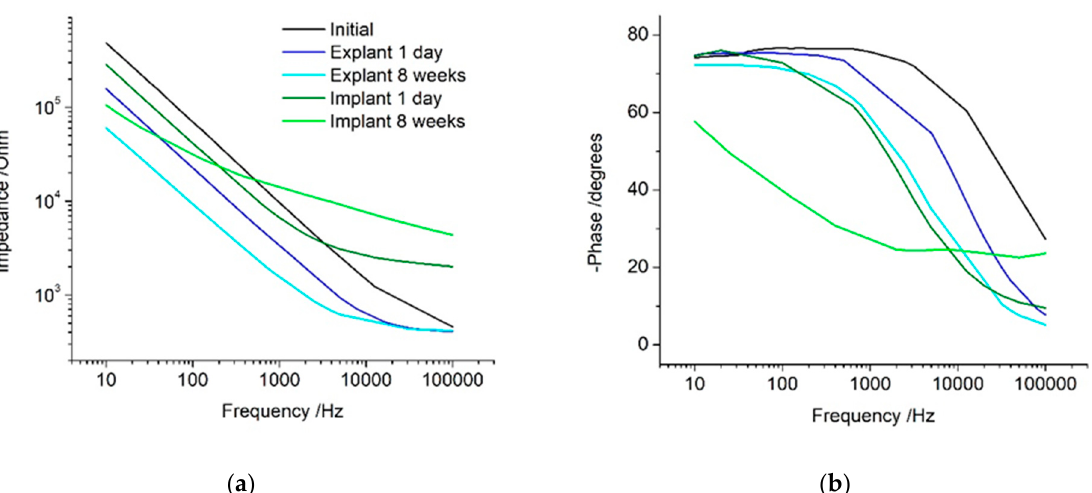
Figure 5. ( a ) Impedance; ( b ) Phase Angle. Electrochemical impedance spectroscopy of a platinum cochlear implant electrode at 0 V with an AC amplitude of 10 mV before cyclic voltammetry. Electrode initially tested in saline, implanted in a cochlea for 1 day, explanted after 1 day, reimplanted in cochlea for 8 weeks, and explanted after 8 weeks.